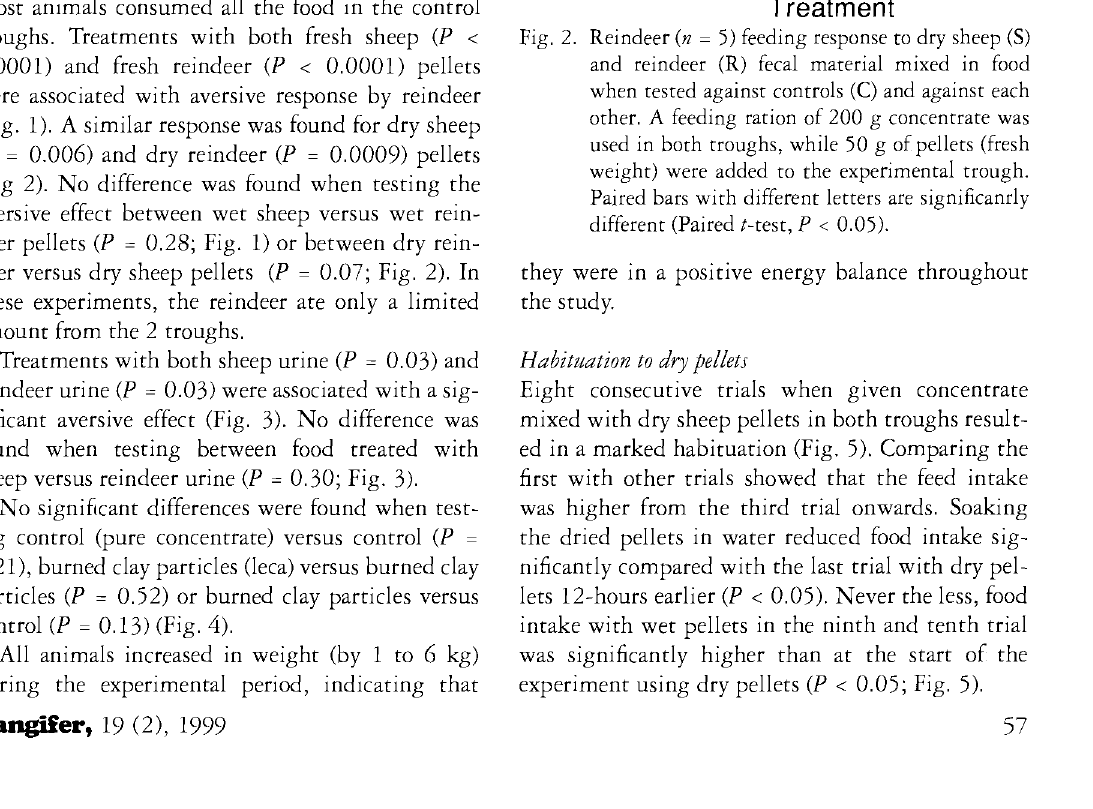
Fig. 2. Reindeer (« = 5) feeding response to dry sheep (S) and reindeer (R) fecal material mixed in food when tested against controls (C) and against each other. A feeding ration of 200 g concentrate was used in both troughs, while 50 g of pellets (fresh weight) were added to the experimental trough. Paired bars with different letters are significanrly different (Paired /-test, P <